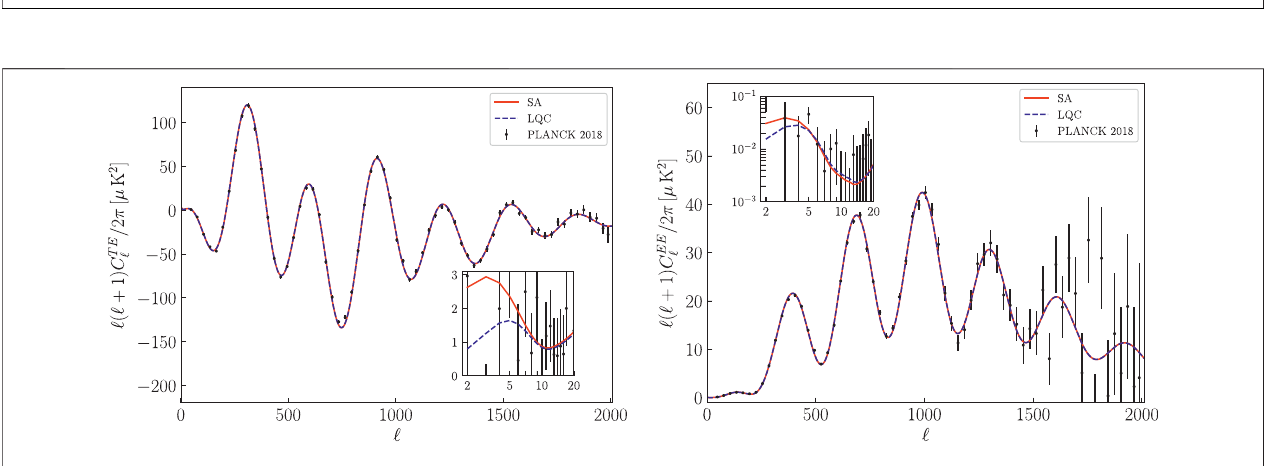
FIGURE 5 | TE and EE power spectra. The 2018 PLANCK spectrum (black dots with error bars), the LQC (dashed (blue) line) and the standard ansatz (SA) predictions (solid (red) line). Values of the 6 Λ CDM parameters are fi xed to their best fi t values shown in Table 1 .